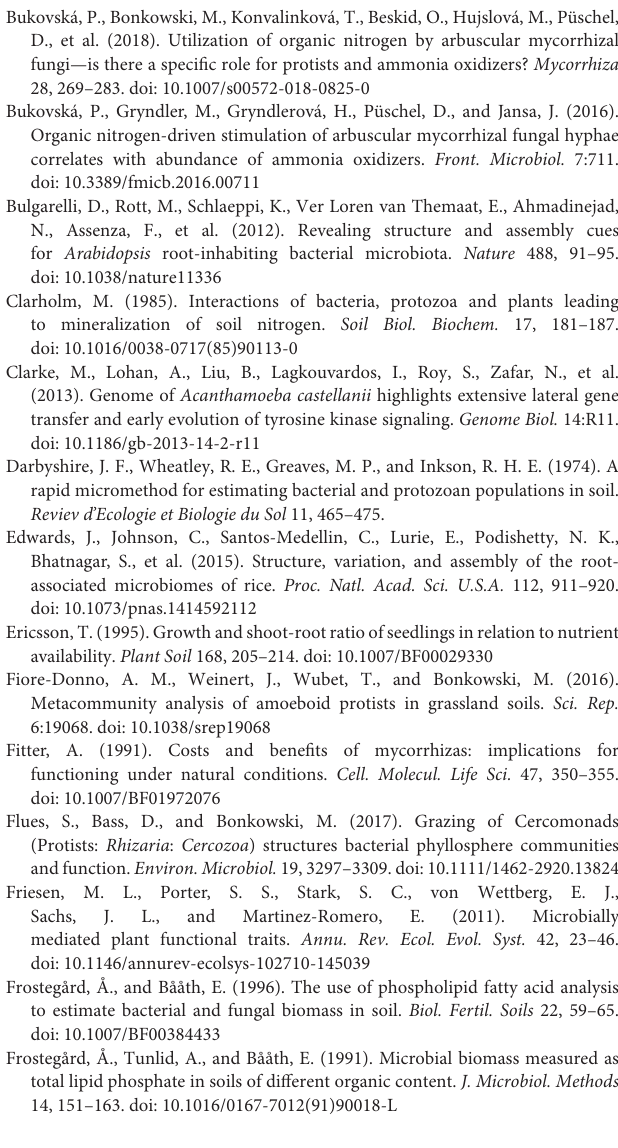
Table S2 | F - and P -values of GLM contrasts showing treatment effects on N concentration (%) of shoots, N (%) of the treated root chambers inoculated with protists or/and mycorrhiza, N (%) of the whole root system, N (%) of the whole plants, and treatment effects on the total use of water of Triticum aestivum. Treatments: control plants (0-0), root halves treated with protists (0-P), with mycorrhiza (0-M), with protists and mycorrhiza together (0-PM), or where the left and right root compartments were separately treated with protists and mycorrhiza (P-M). Nominator and denominator degrees of freedom in brackets. Significant effects p < 0.05 in bold; p < 0.1 in italics. Table S3 | F - and P -values of GLM contrasts showing treatment effects on P concentration (%) of shoots, P (%) of the treated root chambers inoculated with protists or/and mycorrhiza, P (%) of the whole root system, P (%) of the whole Triticum aestivum plants. Treatments: control plants (0-0), root halves treated with protists (0-P), with mycorrhiza (0-M), with protists and mycorrhiza together (0-PM), or where the left and right root compartments were separately treated with protists and mycorrhiza (P-M). Nominator and denominator degrees of freedom in brackets. Significant effects p < 0.05 in bold; p < 0.1 in